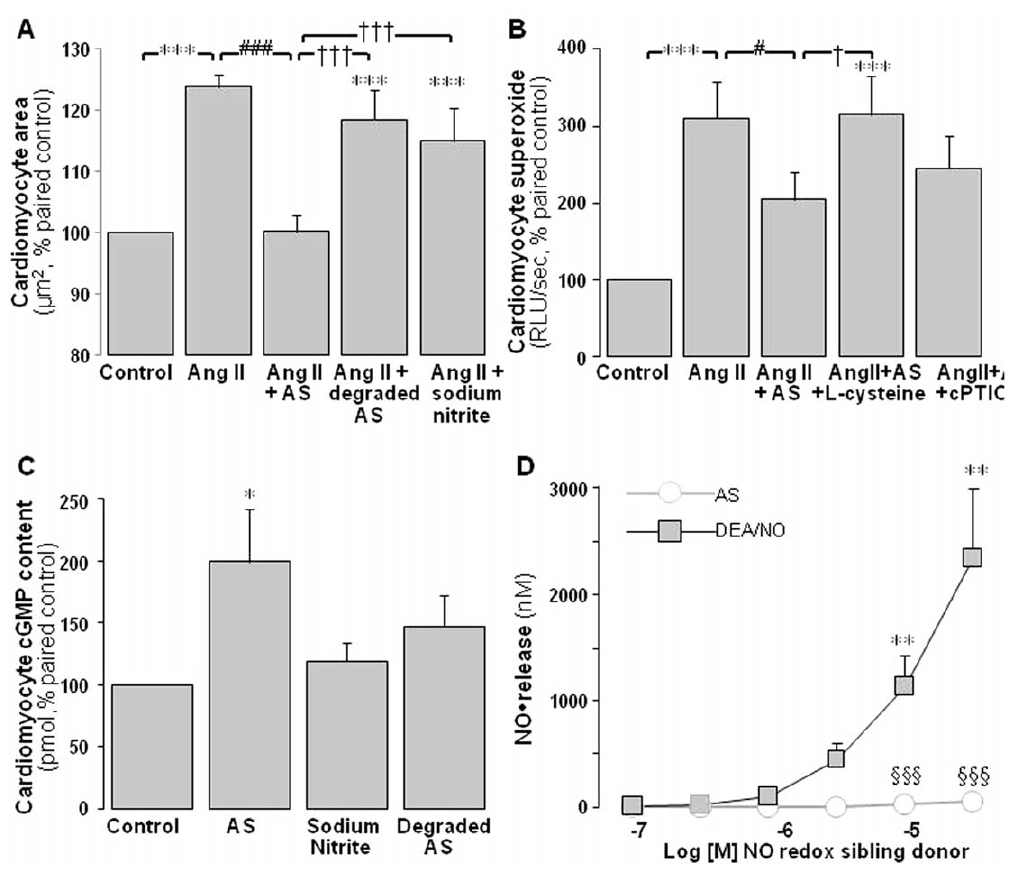
Figure 7. The actions of Angeli’s salt are mediated via HNO. A Neither sodium nitrite (1 m mol/L, co-released by AS) nor degraded AS (1 m mol/ L) significantly attenuate Ang II-stimulated cardiomyocyte hypertrophy on 2D area (n=7 myocyte preparations). B The superoxide-suppressing actions of AS (1 m mol/L, added 4 6 /day over 48 h) are abolished by the HNO-selective scavenger L-cysteine (3 mmol/L) but are preserved in the presence of the NO N -selective scavenger carboxy-PTIO (cPTIO, 200 m mol/L, n=6 myocyte preparations, P , 0.001). C Neither sodium nitrite (1 m mol/L) nor degraded AS (1 m mol/L) significantly stimulate cGMP (both P=NS), in contrast to AS (n=5 myocyte preparations). D Furthermore, the pure NO N donor DEA/NO, but not AS, releases significant amounts of NO N in a concentration-dependent manner over 0.1–30 m mol/L (n=3). *P , 0.05, **P , 0.01 and ***P , 0.001 vs control; # P , 0.05 and ### P , 0.001 vs Ang II alone; { P , 0.05 and {{{ P , 0.001 vs Ang II + AS, 111 P , 0.001 AS vs same concentration of DEA-NO.